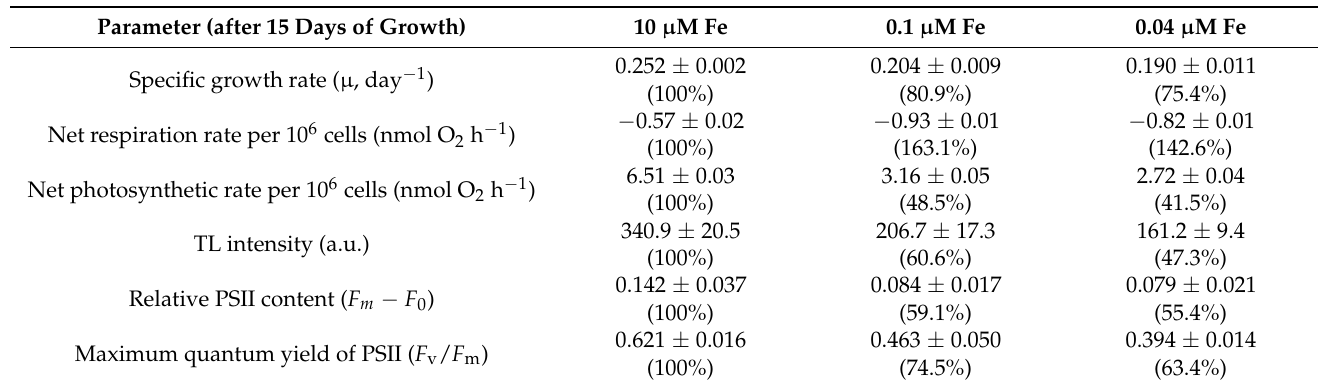
Table 1. Growth and photosynthetic parameters of P. tricornutum cells under different conditions of iron